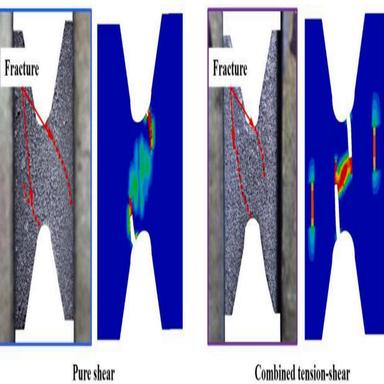
Comparison of the simulated and experimental failure mode of the V-notched specimens in pure shear and combined tension-shear loadings. The position of crack onset and propagation of the combined tension-shear specimen are found to be closer to the central shear zone in the V-notched region than that of pure shear specimen.